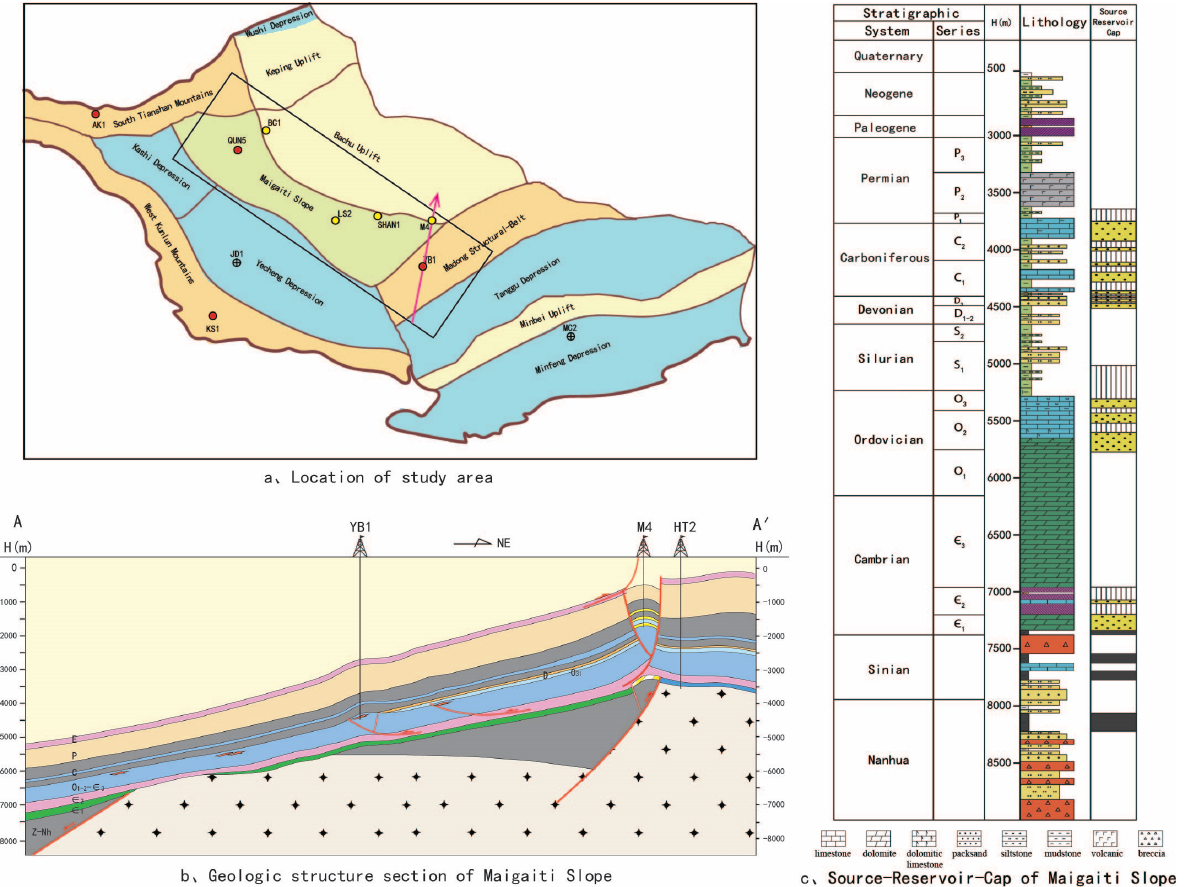
Figure 1. Geological profile map of the study area.